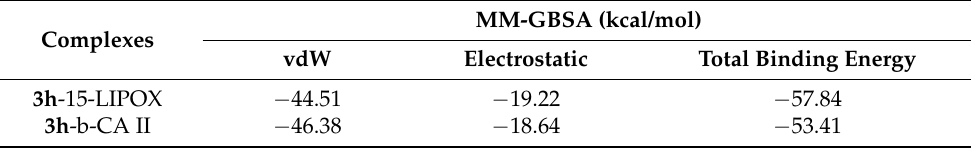
Table 2. Total binding energies of all of the systems. All energies are given in kcal/mol. Complexes